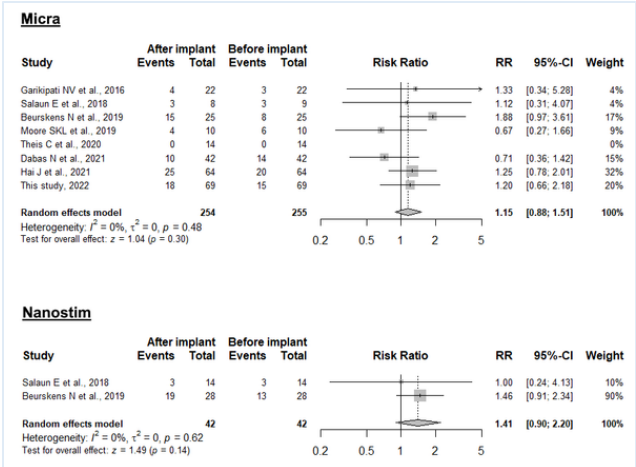
Fig. 2: Meta-analysis of tricuspid valve regurgitation of moderate or se- vere degree (labelled as “event”) before and after implantation of a LLPM (top panel: Micra™ TPS; bottom panel: Nanostim™). Horizontal lines rep- resent 95% confidence intervals. Abbreviations: CI – confidence interval; RR – risk